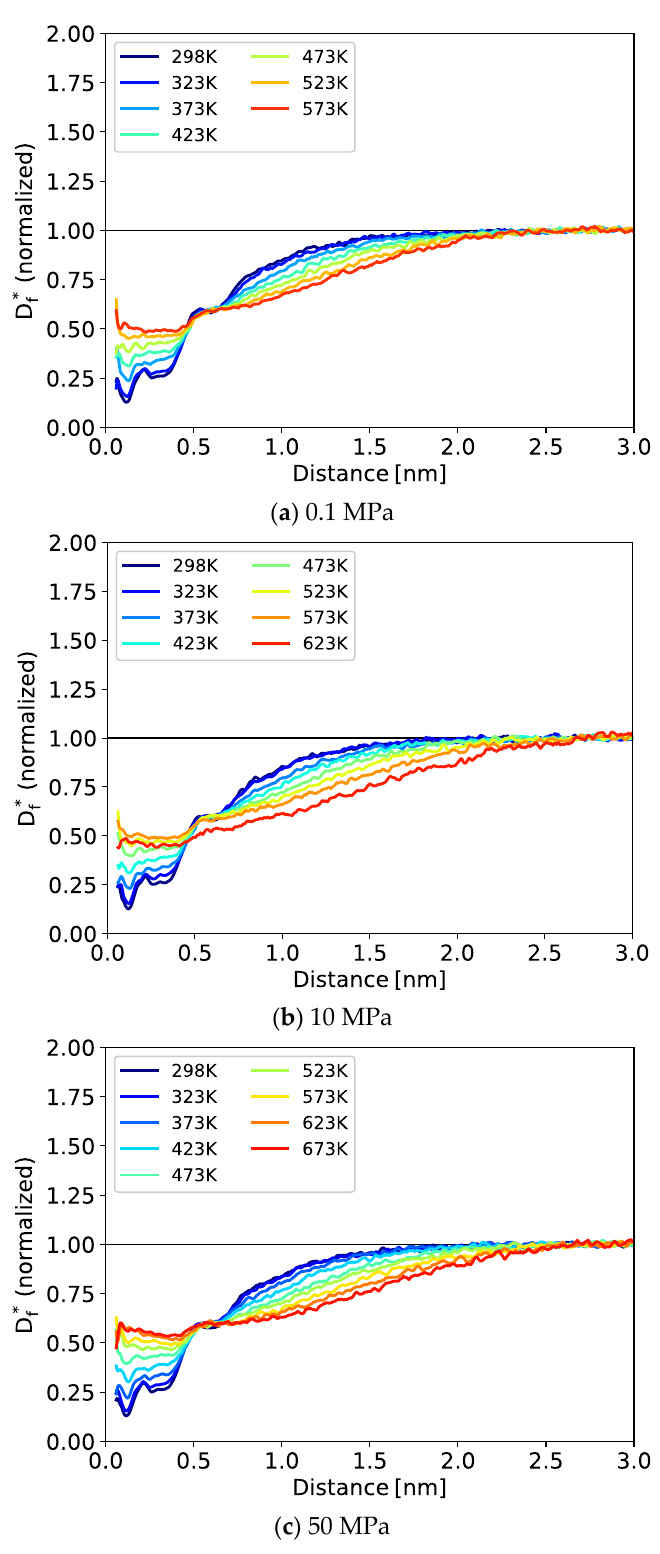
Figure 13. The normalized self-diffusion coefficient of H 2 O molecules D ∗ f ( d ) vs distance from the muscovite surface